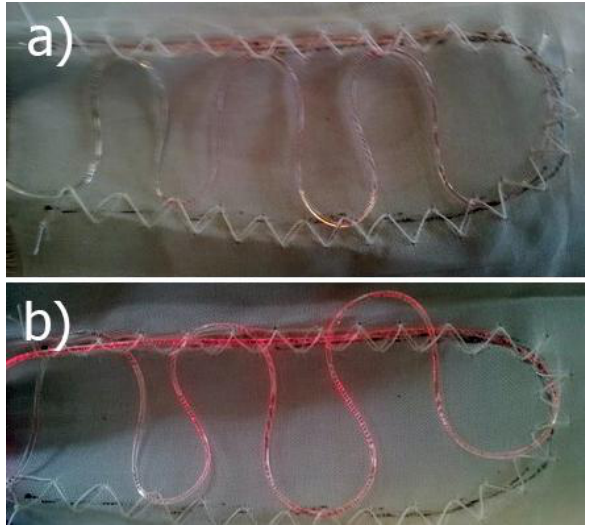
Figure 4. Picture presenting modification of half oval form. In ( a ) fibre was folded without cross points; whereas in ( b ) fibre crossing took place.